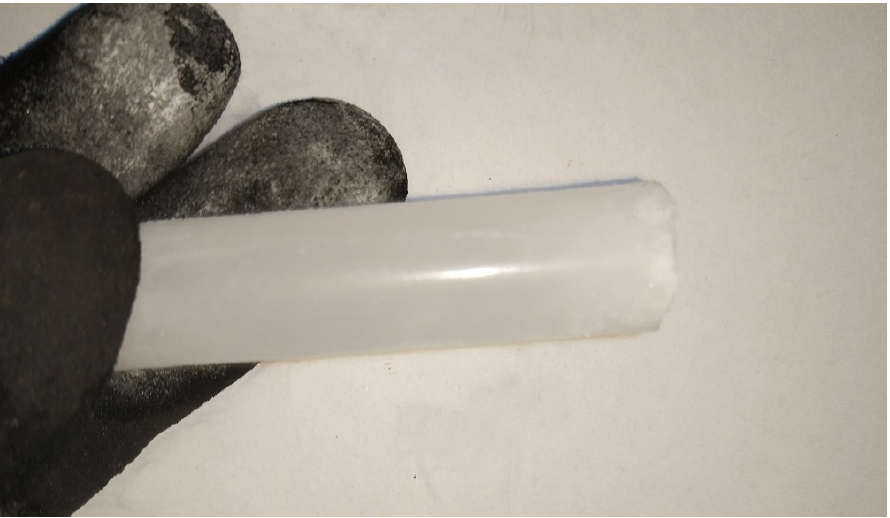
Figure 10. Sample of extruded material of uniform appearance and uniform density